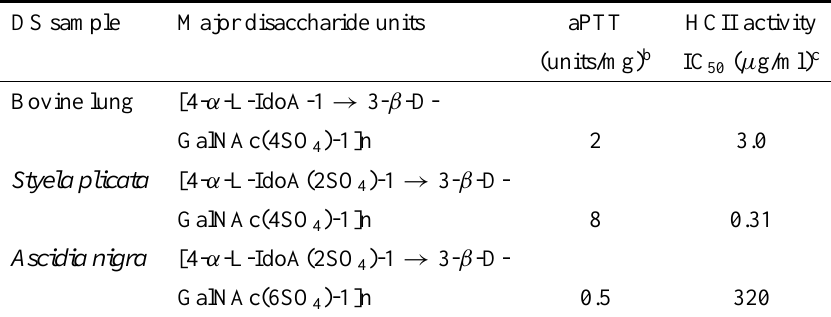
Major repetitive disaccharide units of bovine dermatan sulfate, Styela plicata der- matan sulfate and Ascidia nigra dermatan sulfate, and their anticoagulant proper- ties in vitro a